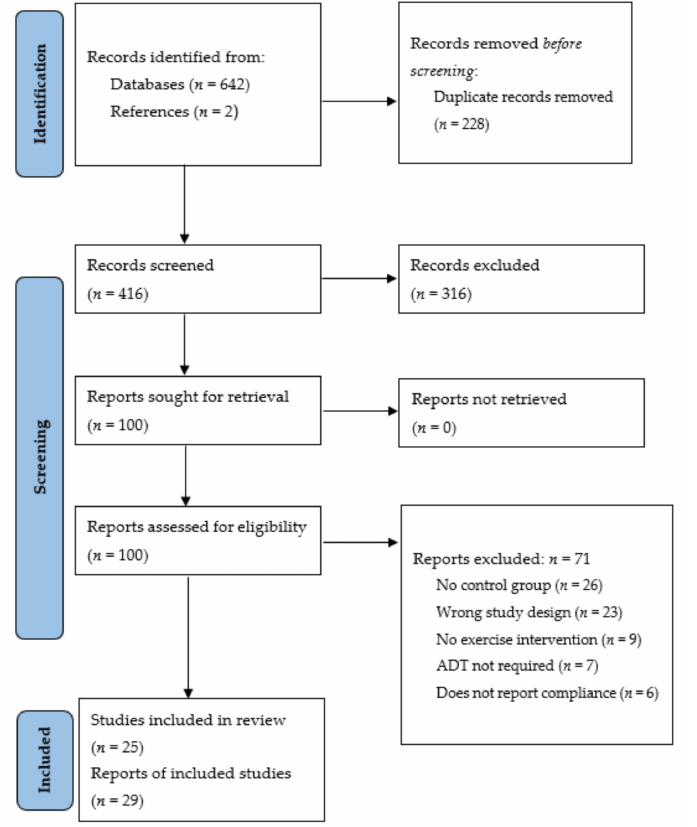
Figure 1. Search strategy and article selection process according to the Preferred Reporting Items for Systematic Reviews and Meta-Analyses (PRISMA) guidelines